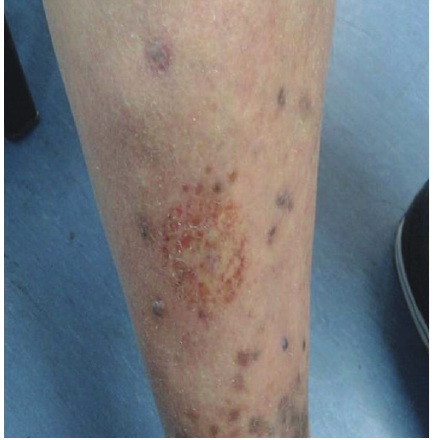
Figure 4: Reddish-purple lesions on the